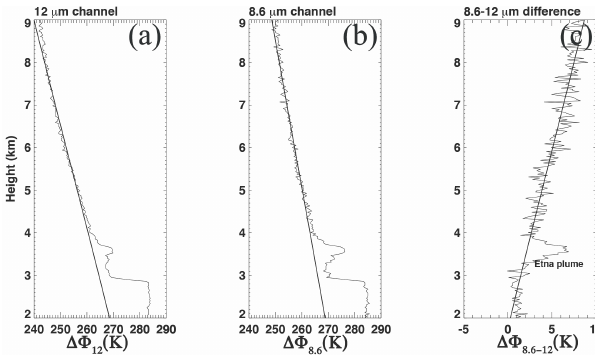
Figure 7. (a) Brightness temperature versus height variation for the 12µm filter ( 8 12 ). (b) Brightness temperature versus height vari- ation for the 8.6µm filter ( 8 8 . 6 ). (c) Brightness temperature dif- ference versus height variation for the 8.6–12µm fiters ( 18 8 . 6 , 12 ). The straight lines are least-squares linear fits based on profile data above the plume, and extrapolated through and below the plume.